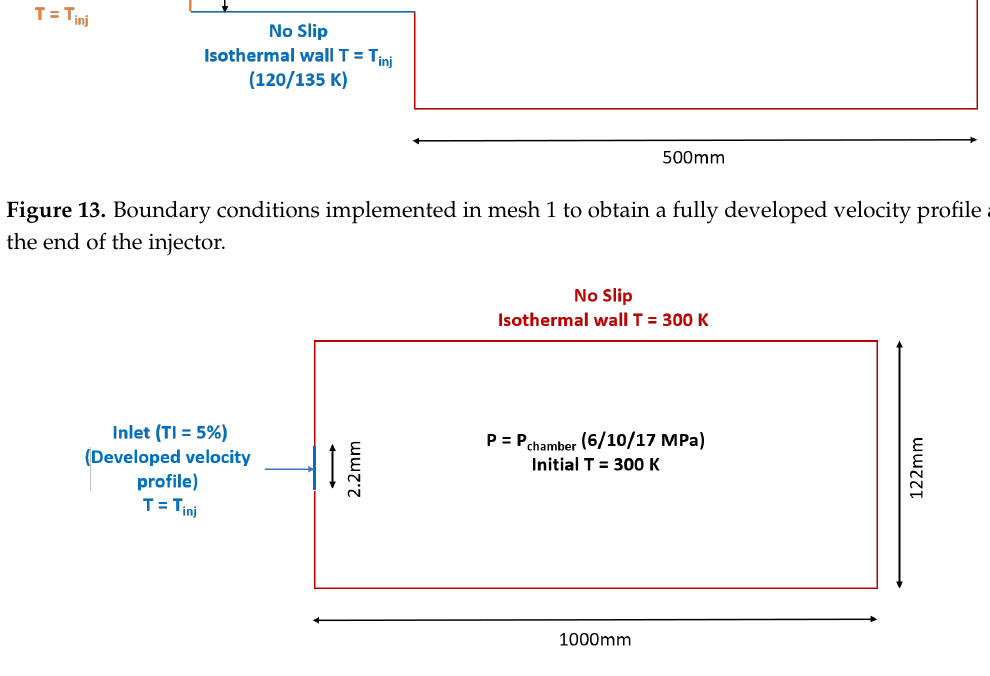
Figure 14. Boundary conditions implemented in mesh